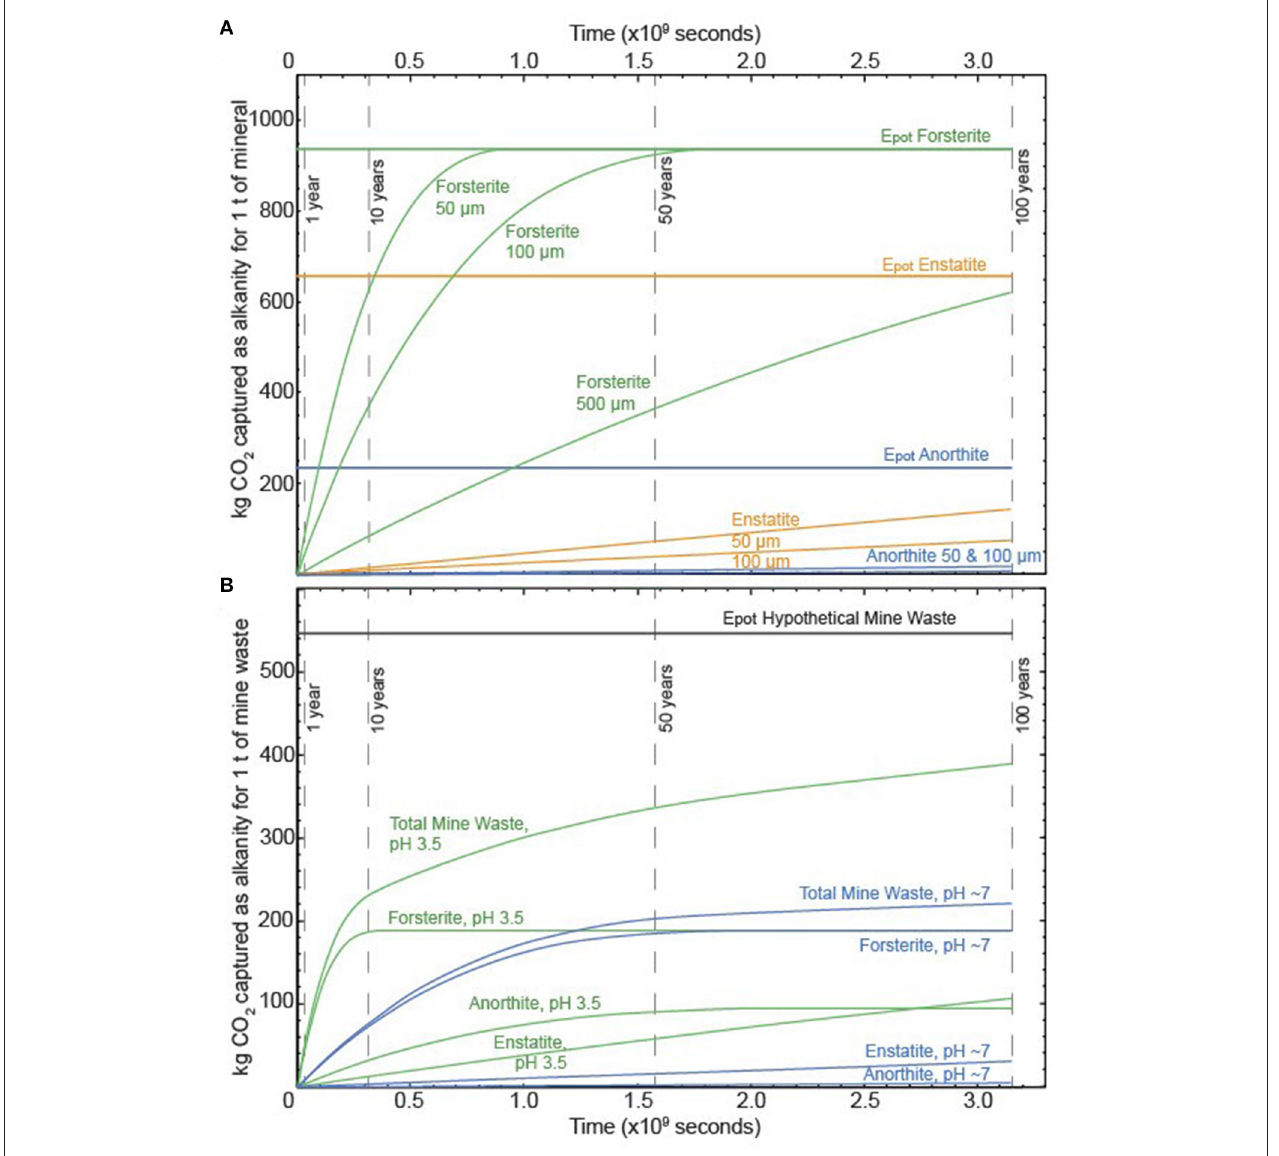
FIGURE 4 | Alkalinity production through enhanced weathering of selected minerals and mine waste with time. (A) Cumulative CDR by weathering in ambient ( ∼ 25 ◦ C) near-neutral pH conditions (pH ∼ 7) for olivine Mg-end member forsterite (Fo), orthopyroxene Mg-end member enstatite (En), and plagioclase Ca-end member anorthite (An) as these are common minerals in some major ore types such as Cr and PGM deposits. End member compositions are used because experimental dissolution rates are available for these phases. We acknowledge that solid solutions to iron-bearing mafic minerals and sodic feldspars are most commonly present in nature. The E pot for each mineral was calculated using Eq. 5, and dissolution time trajectories calculated using a shrinking grain model (following Kelemen et al., 2020) for 1t of mineral of a uniform grainsize (50, 100 and 500 µ m) using W r for near-neutral pH conditions (log W Fo r = − 9.3; W En r = − 11; W An r = − 12, after Bandstra et al., 2008). Finer grains dissolve more quickly and alkalinity production would increase by approximately one order of magnitude if a more realistic grainsize distribution is used (as shown in Kelemen et al., 2020). Only relatively fine-grained olivine (100 µ m or less) weathers completely on decadal time scales ( < 50 years). (B) Cumulative CDR by enhanced weathering in ambient ( ∼ 25 ◦ C) conditions of 1t of hypothetical mine waste comprising 100 µ m grains of 20% Fo, 40% En and 40% An, which is representative of mafic rocks that host Cr and PGM deposits. At near-neutral conditions (blue lines) olivine (Fo) dissolution provides ∼ 85% of the alkalinity with only minor contribution from En, and there is only a very slow increase in alkalinity after 50 years due to the exhaustion of the Fo reservoir. At more acidic, pH = 3.5 conditions (green lines), as might be achieved by CO 2 -saturated water, reaction rates are significantly increased, all available Fo is consumed within 10 years (log W Fo r = − 8.5), and An weathering is complete in ∼ 50 years (log W An = − 10). Pyroxene dissolution rates are poorly determined and highly variable (Bandstra et al., 2008) r with experiments to date suggesting only a slight increase in dissoluton rates (log W En r = − 10.4) for pH 3.5. Consequently, for this hypothetical mixture, almost 30% of the potential alkalinity is unrealised even after 100